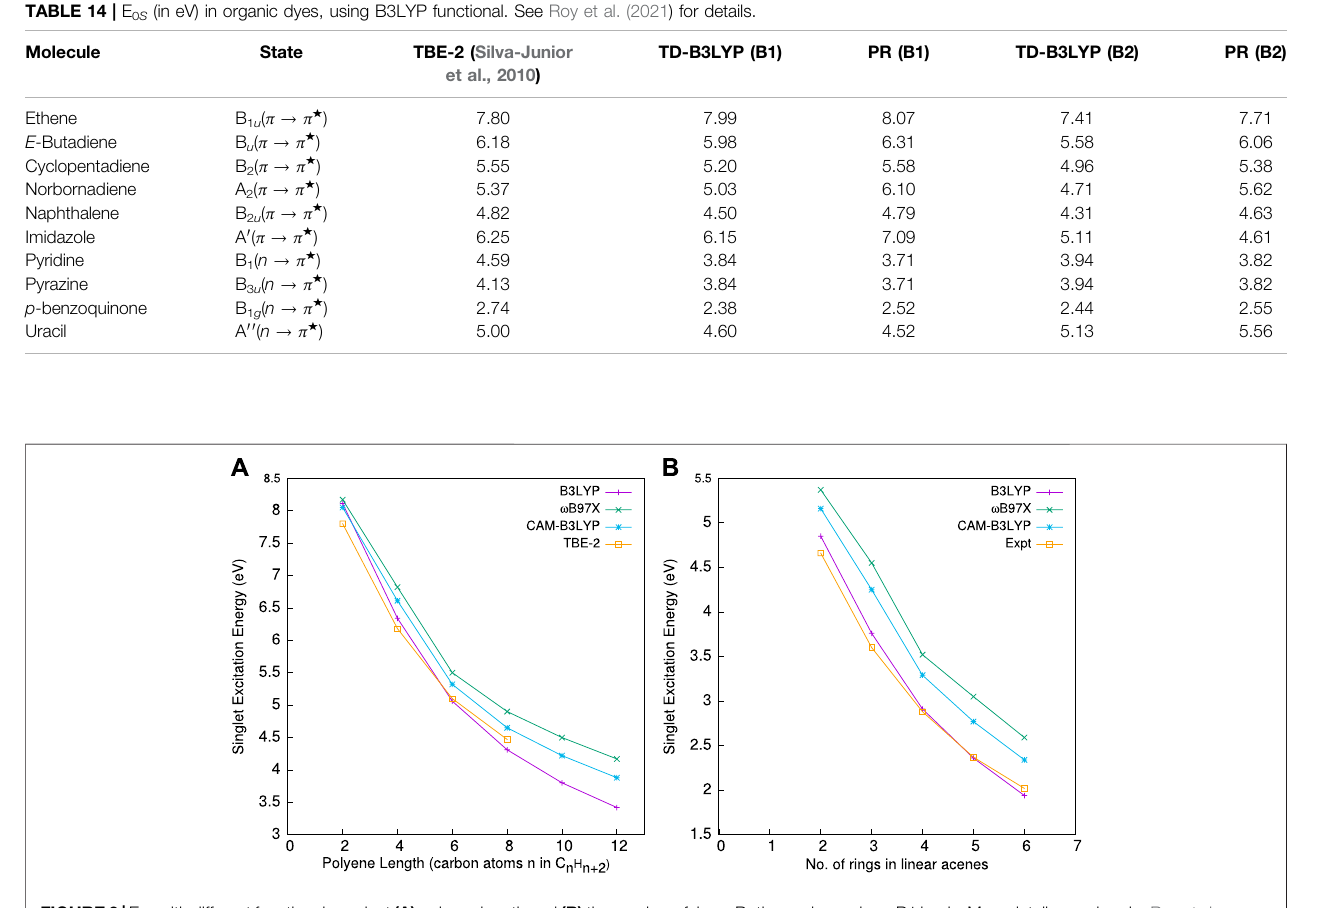
Frontiers in Chemistry |